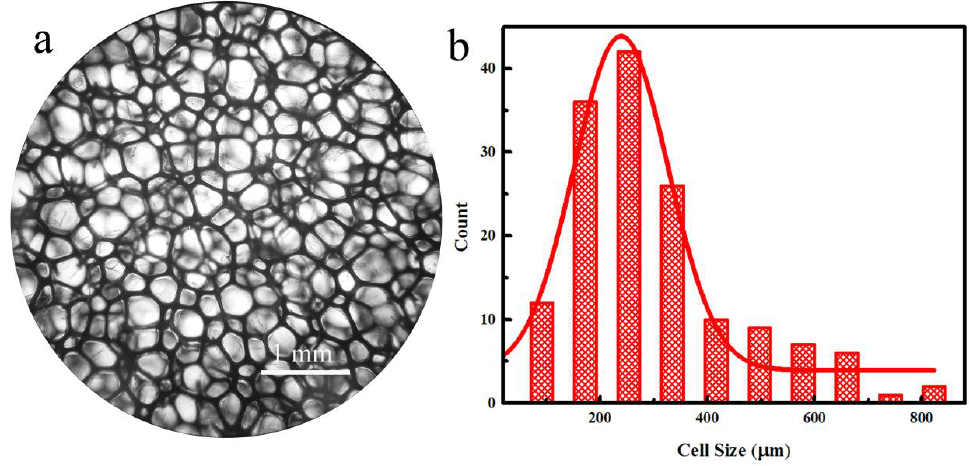
Figure 3. ( a ) Cell morphology and ( b ) cell size distributions of PUFM composites.